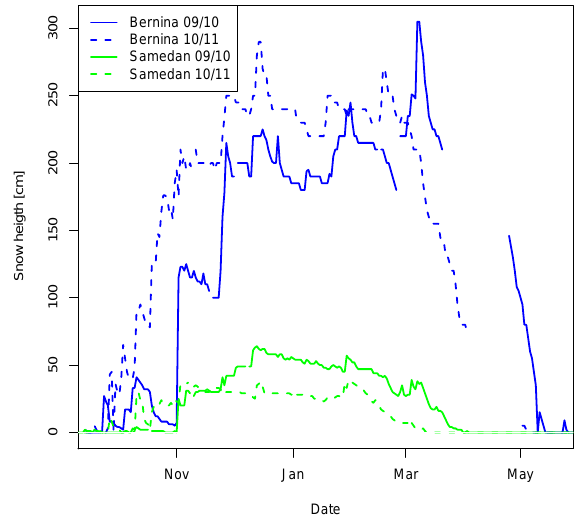
Fig. 3. Snow height at Passo del Bernina and Samedan during the winters 2009/10 and 2010/11 (source: